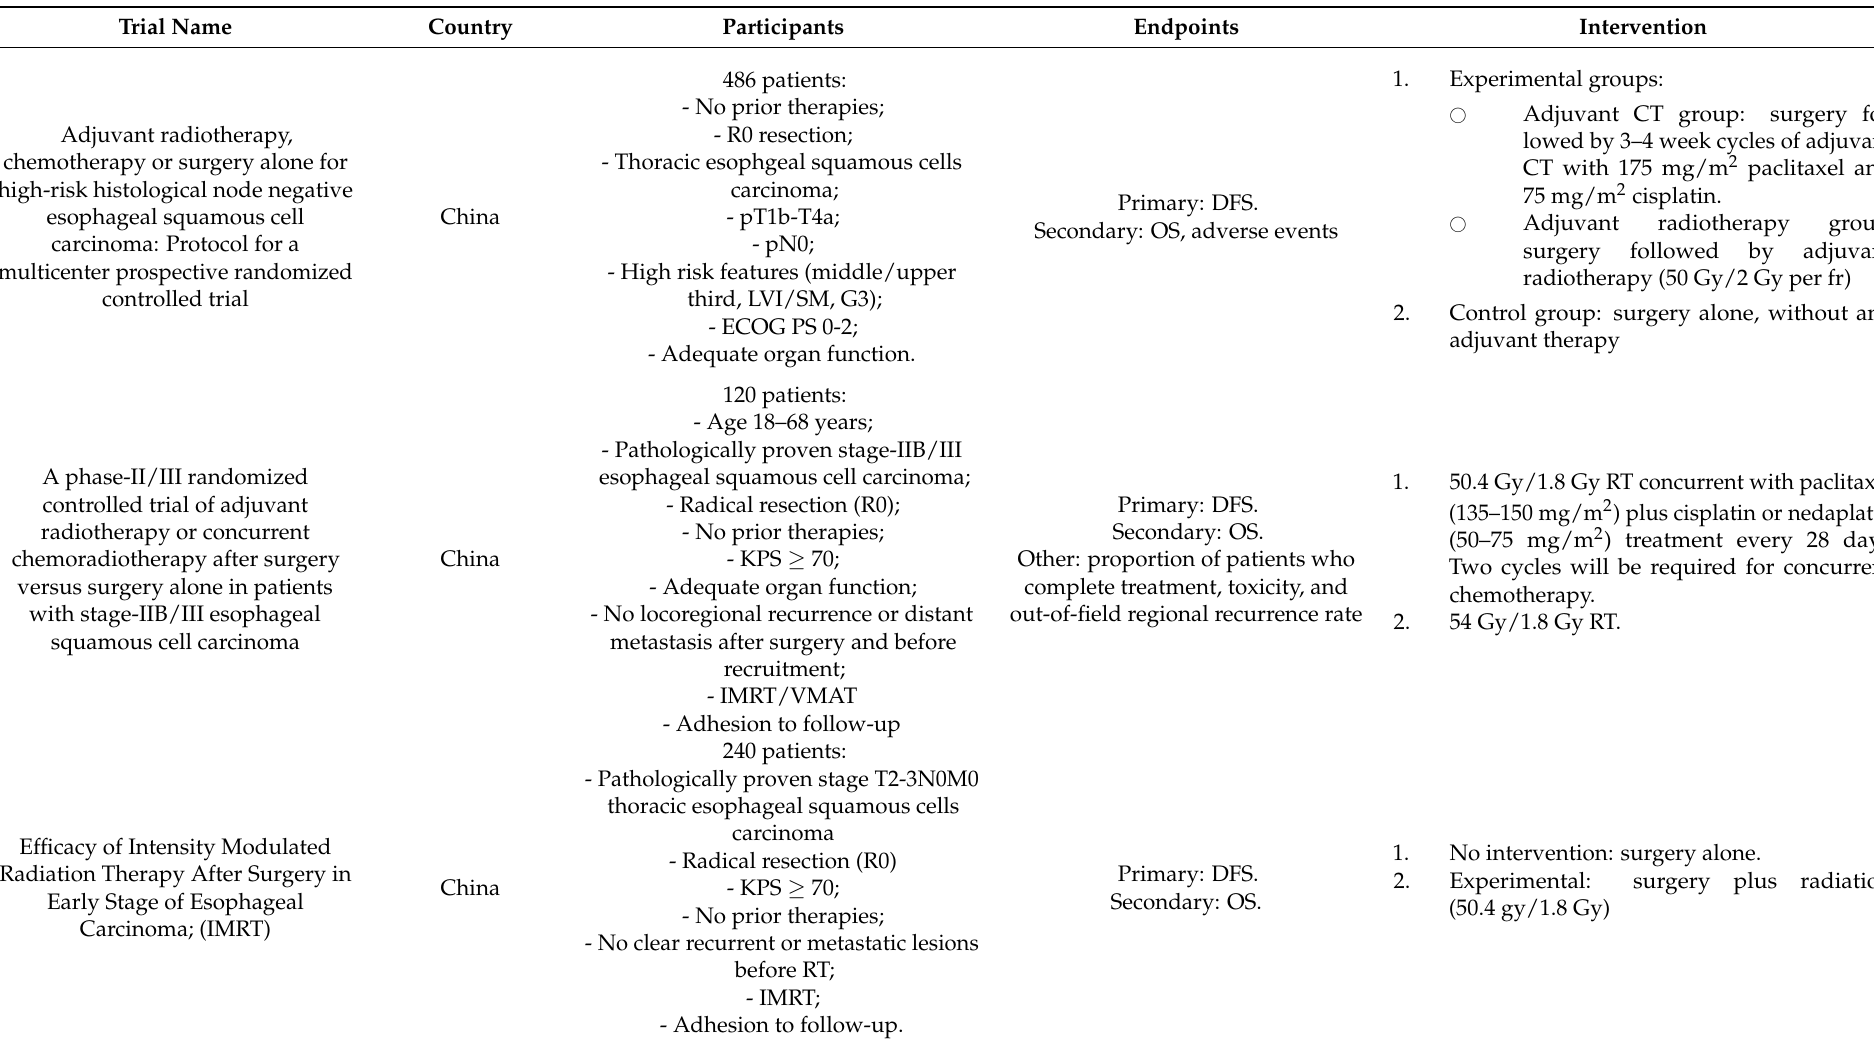
Table 2. Design and main characteristics of ongoing trials for post-operative radiochemotherapy in esophageal and gastroesophageal